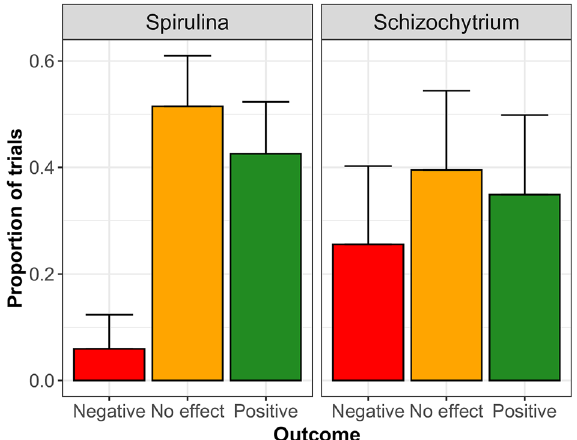
Figure 10. Breakdown of study outcomes (SMDs) under a random effects model for the Schizochytrium and Spirulina meta-analyses, showing the proportion of statistically significant negative effects, no effect, and positive effects along with the 95% binomial CI. The distribution of non-negative outcomes is significantly better for Spirulina than for Schizochytrium studies ( χ 2 = 11.197, df = 2, P =